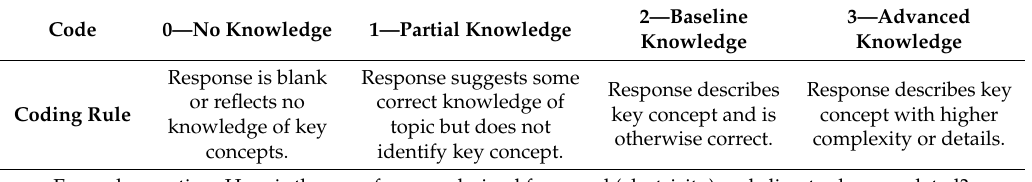
Table 4. Level of knowledge coding rule and example responses to open-ended survey